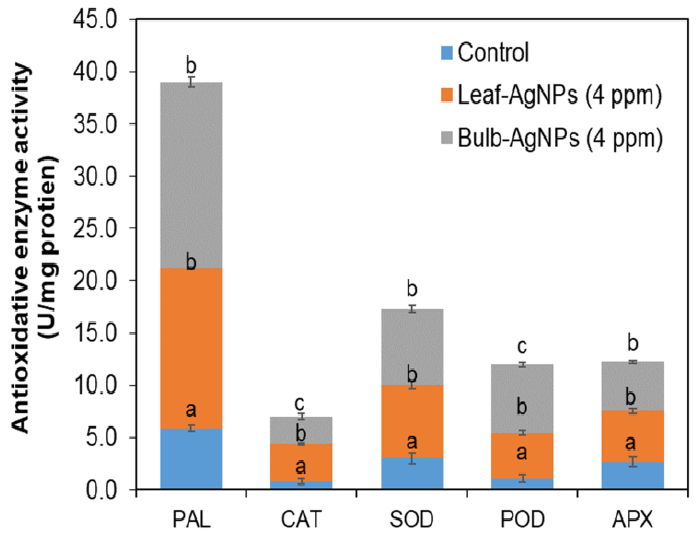
Figure 11. Effects of leaf-AgNPs and bulb-AgNPs on activities of antioxidative enzymes (PAL, CAT, SOD, POD, and APX, in U/mg protein) in Solanum tuberosum L. plantlets grown under a controlled environment in in vitro conditions. Values are the mean ± standard error from three replicates. Different letters indicate a significant difference ( p < 0.05) in values between control and treated plantlets.